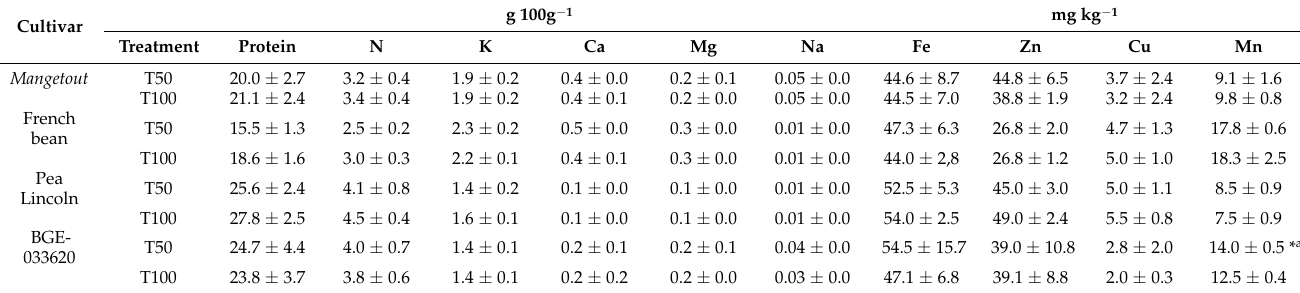
The minimum and maximum mean mineral content (dry weight) in each cultivar were: 2.5 (French bean) and 4.5 g 100 g − 1 (pea cv. Lincoln) of N; 1.4 (peas) and 2.3 g 100 g − 1